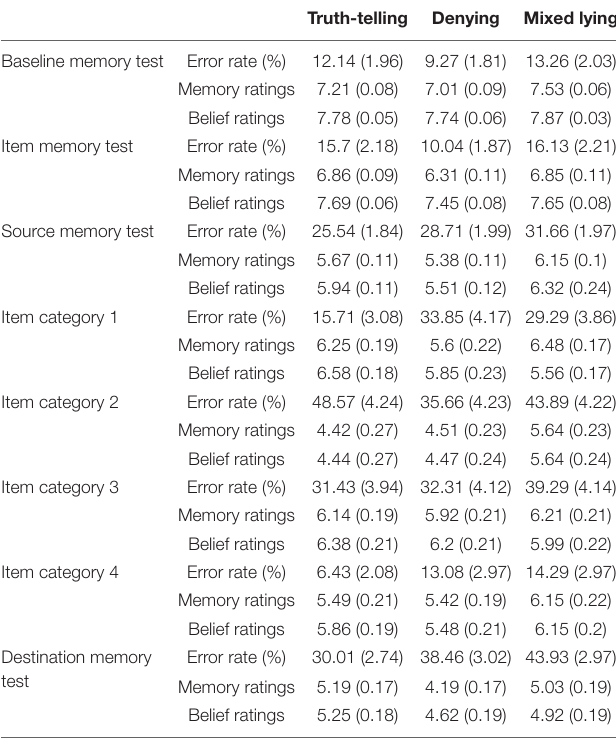
TABLE 1 | Mean error rates and belief and memory ratings with correct responses in memory tests for each condition. Truth-telling Denying Mixed